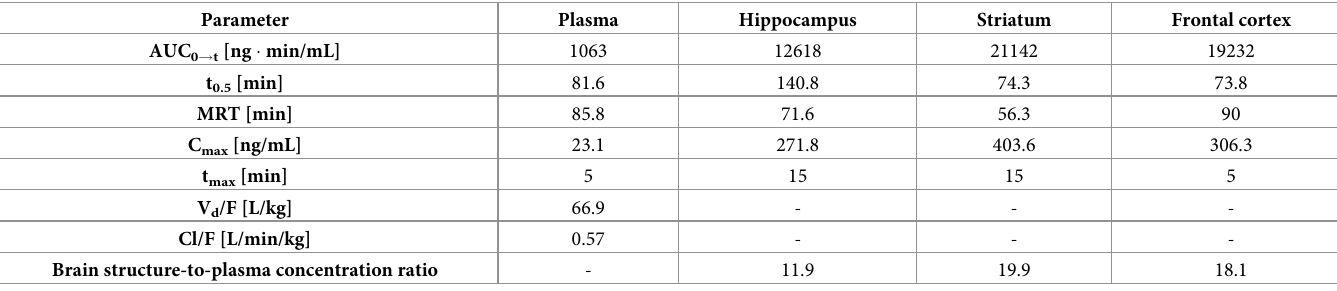
Table 3. Pharmacokinetic parameters and brain structure uptake for AZ-853. Parameter Plasma Hippocampus Striatum